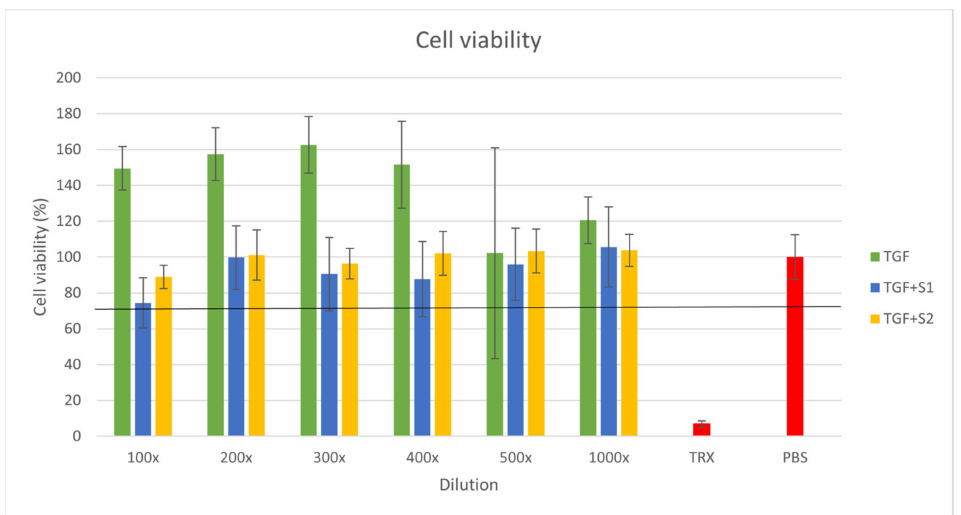
Figure 9. MTT cell viability assay results for Caco-2 cells. Cell viability expressed as the percentage of the negative control (PBS). Each data point represents the mean ± S.D. of 6 independent parallel wells. The cell viability was over 70% for every composition in each concentration. The Triton X-100 treatment used as positive control resulted in 6.7% cell viability. An ordinary one-way ANOVA test followed by a Tukey’s multiple comparison test was performed to compare the different